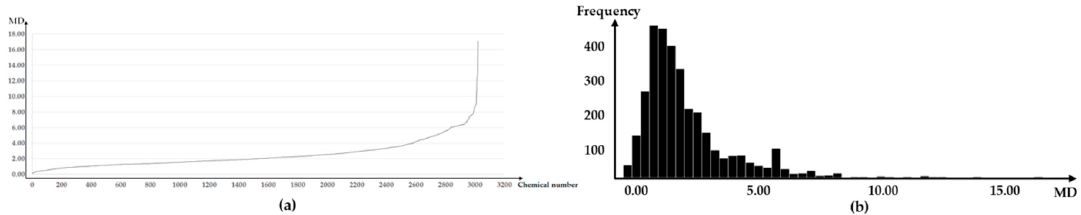
Figure 2. MD distribution of 3028 chemicals: ( a ) Distribution of MDs in ascending order; and ( b ) frequency distribution of MDs.